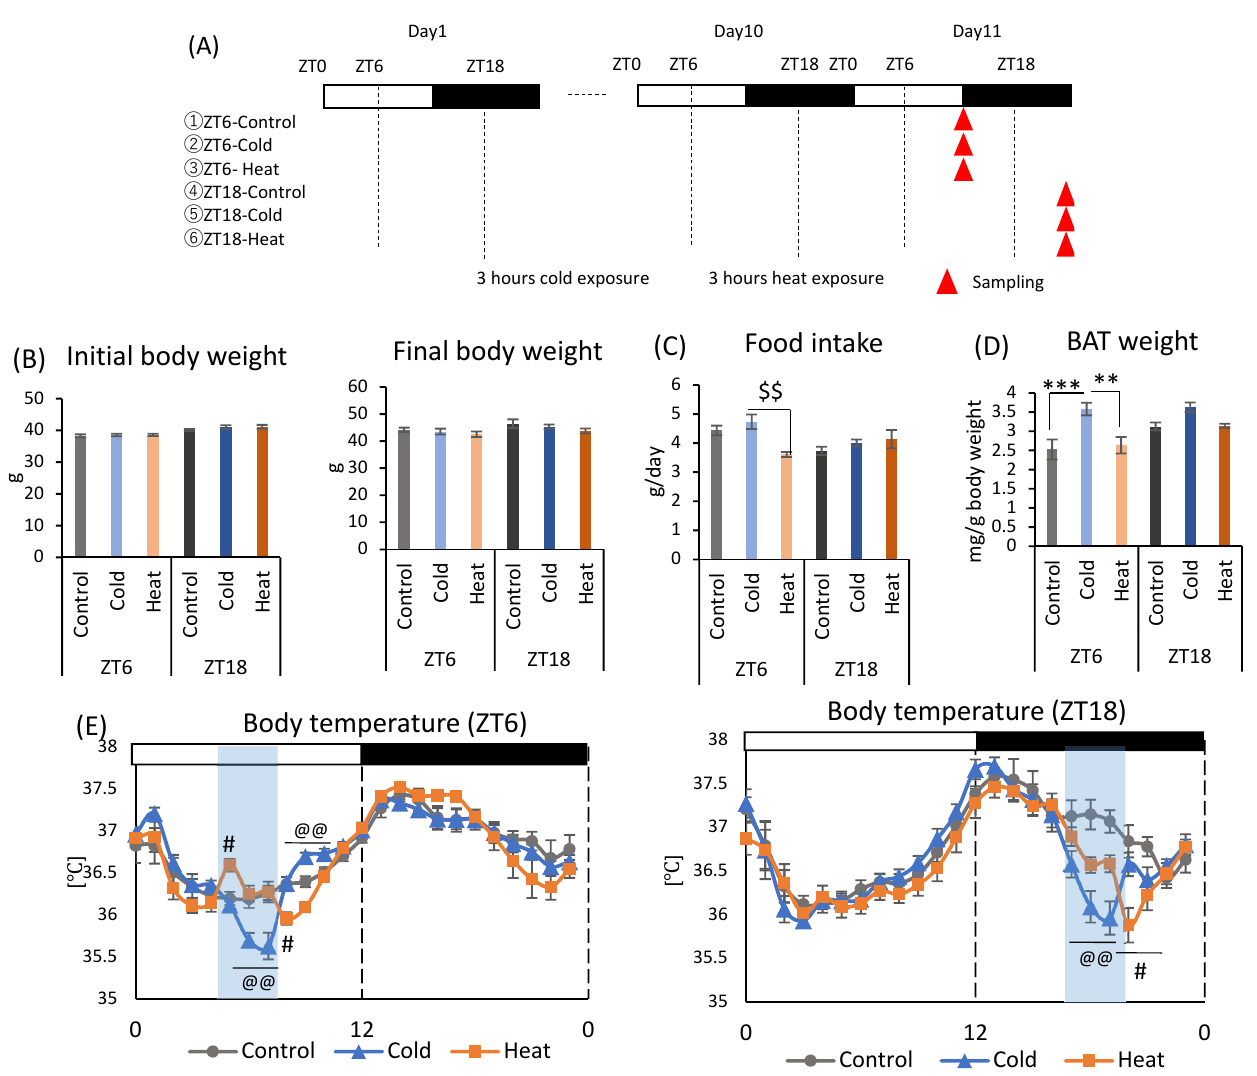
Figure 2. Effects of cold or heat exposure on body weight, food intake, and BAT weight. ( A ) Experimental design; ( B ) Initial body weight on day 1, final body weight on day 10. ( C ) Food intake per animal per day. ( D ) BAT weight corrected by body weight. ( E ) Body temperature of mice exposed to 22 or 7 or 37 ◦ C. Data are represented as mean ± SEM ( n = 7). ** p < 0.01, *** p < 0.001 evaluated using one-way ANOVA with Tukey’s post hoc test. $$ p < 0.01 evaluated using the Kruskal– Wallis test with a two-stage linear step-up procedure of the Benjamini, Krieger, and Yekutieli test for multiple comparisons. @@ p < 0.01 evaluated using one-way ANOVA with Tukey’s post hoc test for control vs. cold group. # p < 0.05 evaluated using one-way ANOVA with Tukey’s post hoc test for control vs. heat group.